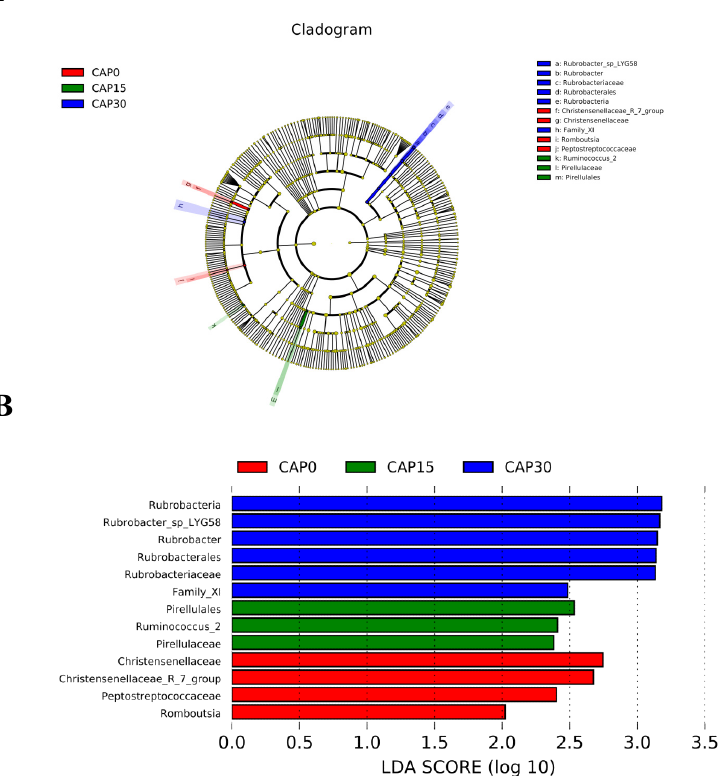
Figure 5. LEFSE (Linear discriminant analysis Effect Size) analysis identified bacterial species that differed significantly in abundance among groups. ( A ) Differences in bacterial species abundance were represented by the color (red indicates a significantly higher relative abundance in the CAP0 group, green indicates a significantly higher abundance in the CAP15 group and blue indicates a significantly higher abundance in the CAP30 group). ( B ) Linear regression analysis (LDA) was used to estimate the magnitude of the effect of the abundance of each bacterial species on the differential effect. Functional analysis of PICRUSt2 prediction of intestinal bacterial flora revealed the top 20 level-2 KO groups. From the plot, the KEGG pathways in CAP15 were more enriched than those in CAP0, but the degree decreased as the level of CAP substitution rose (Figure 6). Among them, the microbiota of the CAP15 group upregulated the pathways of amino acid metabolism, lipid metabolism, metabolism of cofactors and vitamins and membrane